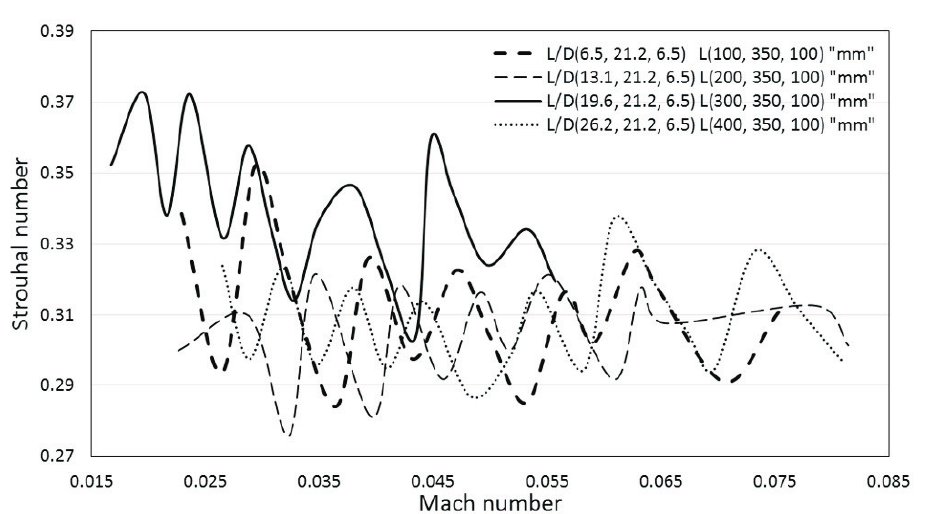
Figure 18. Strouhal number St plotted against Mach number M for L up = 100–400 mm, L corr = 350 mm, and L dw = 100 mm. Table 14. Mach number range, corresponding Strouhal number ( St ) range and maximum Strouhal number for each pipe configuration in Case b-II.